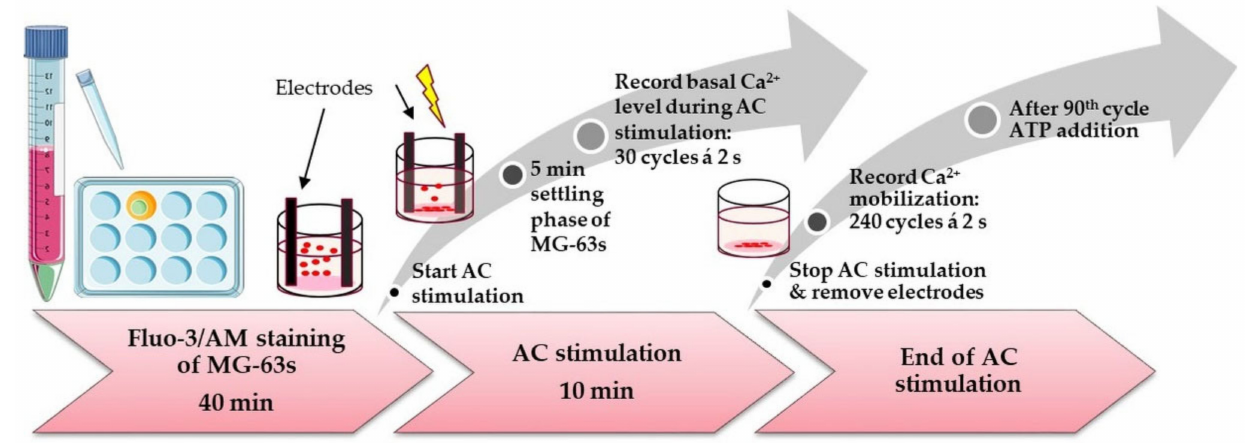
Figure 2. Scheme of experimental approaches of AC stimulation and calcium ions (Ca 2+ )-imaging in confocal microscopy. At first, we stained the suspended MG-63s with fluo3/AM for 40 min. Stained cells were then seeded into the 12-well plate under the microscope (LSM780, Carl Zeiss). Next, the electrodes were placed, and the electrical stimulation started. After a short settling phase of cells, a time series was done to measure the basal Ca 2+ activity during ES (60 s). After 10 min ES, the electrodes were removed, and a second time series was recorded immediately to analyze the Ca 2+ release and reaction after ATP addition (480 s; 240 cycles each 2 s, after 180 s ATP addition). (Parts of the figure were drawn by using pictures from Servier Medical Art. Servier Medical Art by Servier is org/licenses/by/3.0/, accessed on 21 July